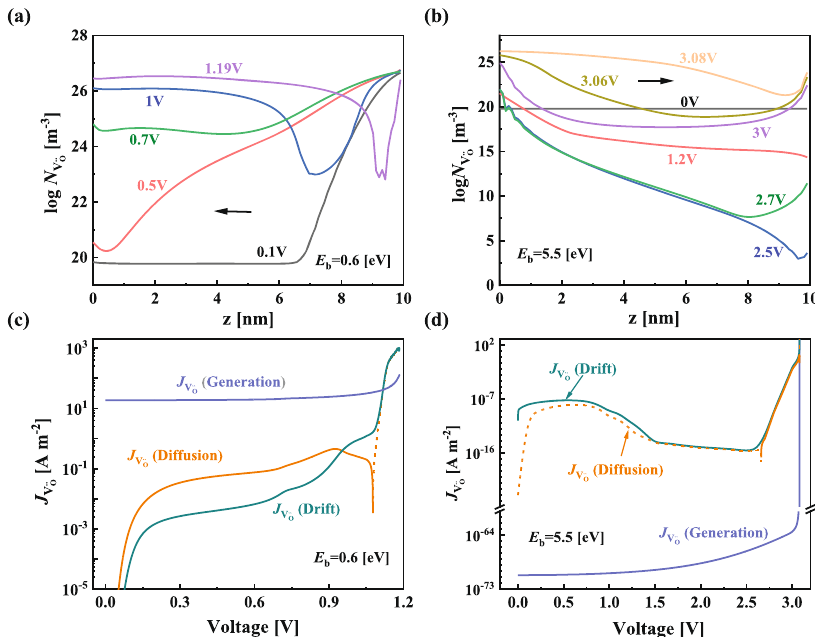
Fig. 3 The competition between generation rate and migration rate. a , b The evolution of distributions of N V :: z = 0 – 10 nm) with an active electrode Ti and an inner electrode W under a voltage sweep rate d V /d t = 1 V s − 1 . c , d . The generation fl ux at the point in interface ( x = 0, z = 10 nm), the drift and diffusion fl ux at the point near the anode ( x = 0, z = 8.5 nm) with Ti and W electrodes, respectively. Flux direction from anode to cathode is marked as solid line, while fl ux direction from cathode to anode is marked as dotted